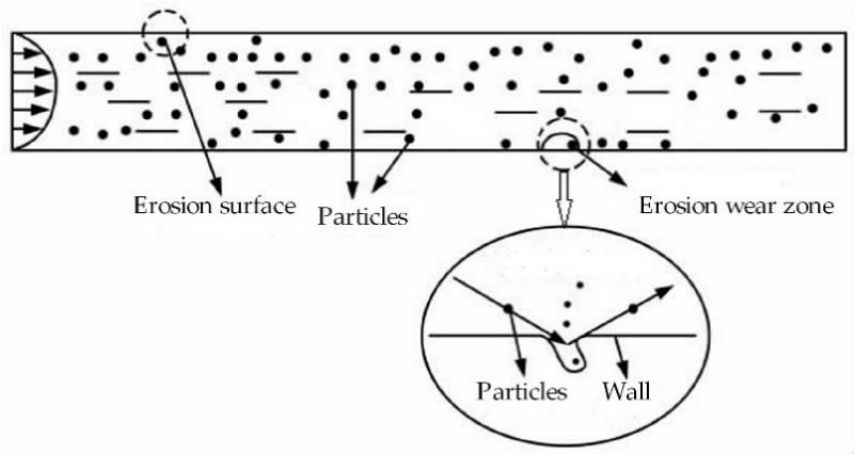
Figure 1. Schematic diagram of pipeline wall erosion and wear.